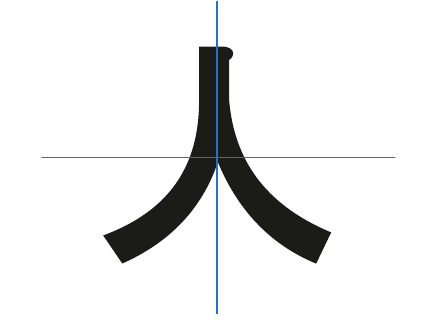
Figure 2: Cross-feature extraction.